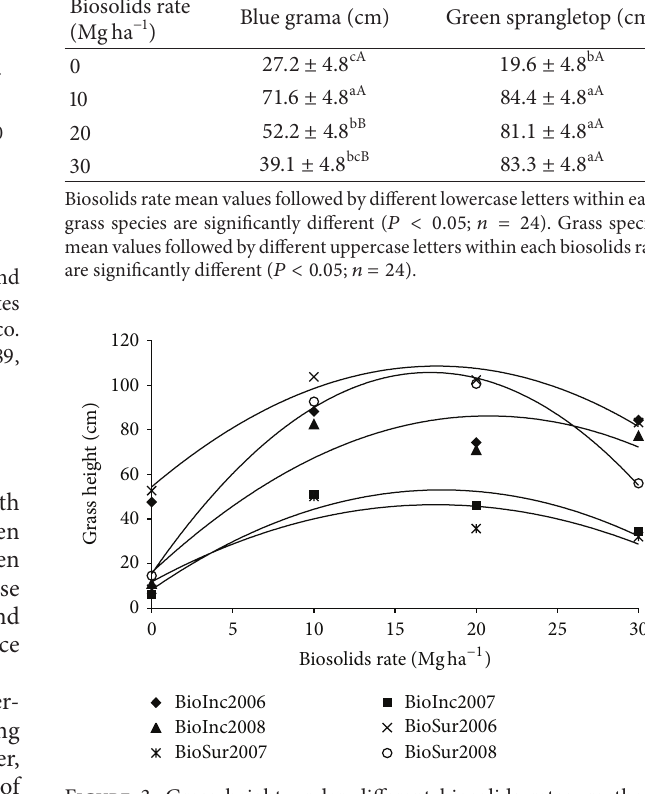
= no linear ( 𝑃 = BioInc 2006 = BioInc 2007 = BioInc 2008 = BioSur 2006 = BioSur 2007 = BioSur 2008